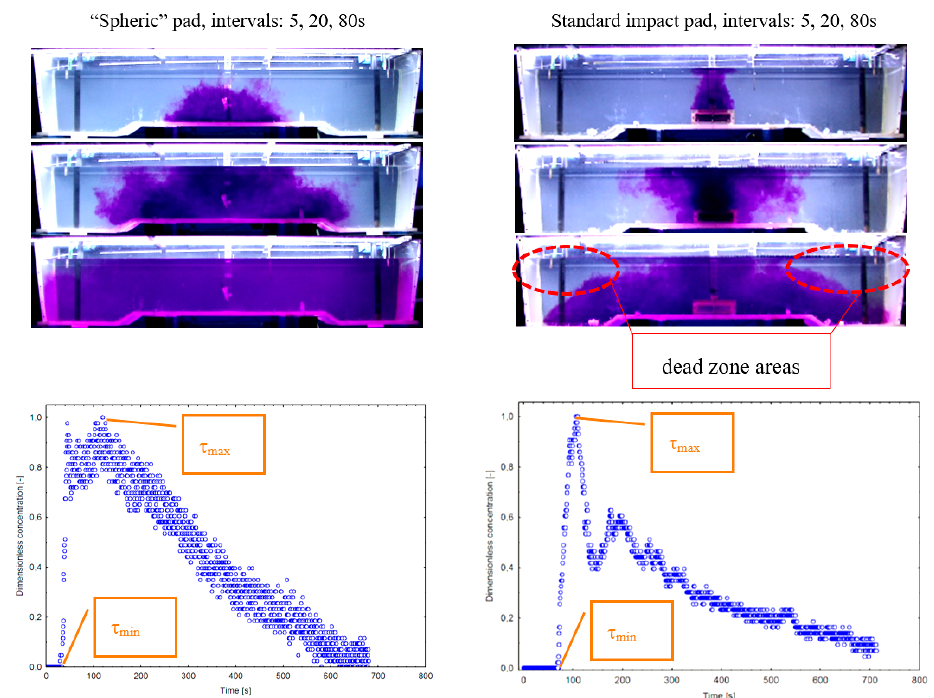
Figure 6. Visual and graphical comparison of flow for “Spheric” impact pad and for standard impact pad at simulated casting speed 0.8 m · min − 1 —physical simulation.